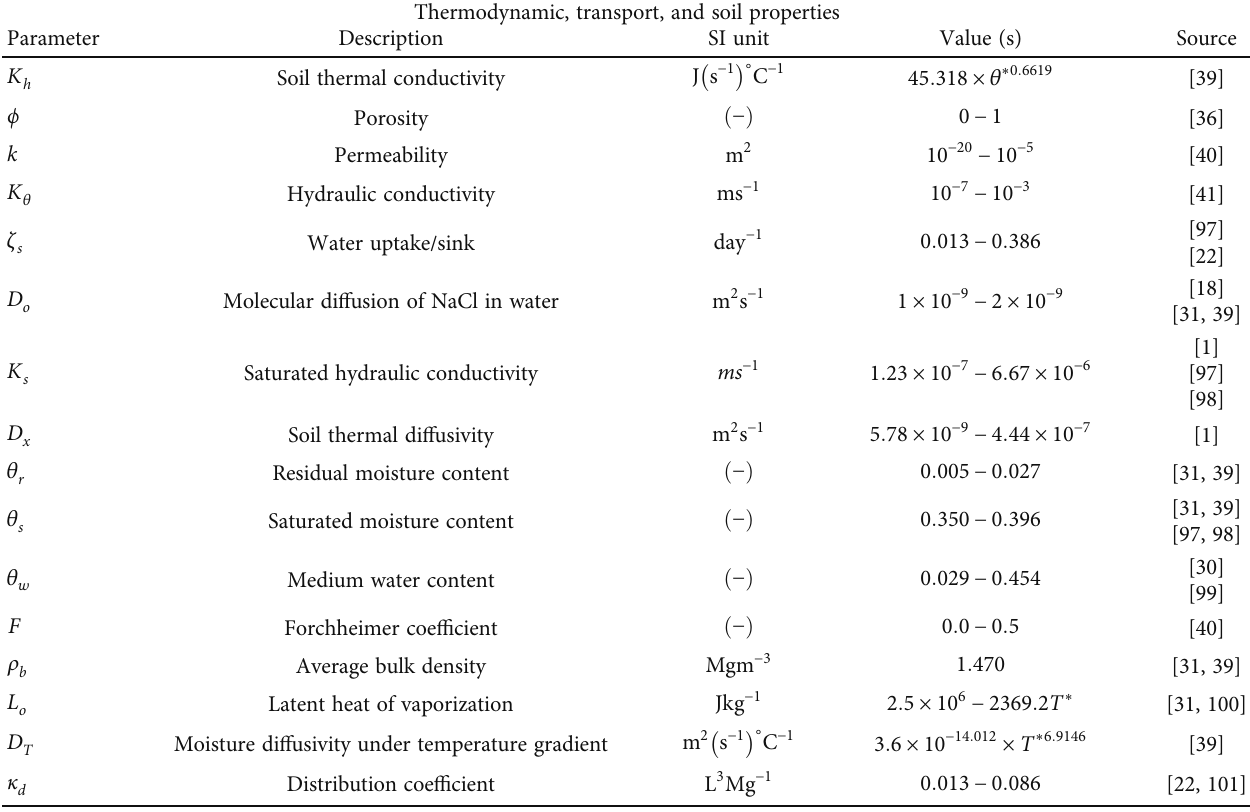
Table 2: Parameter values for loamy sand soil considered for laminar fl